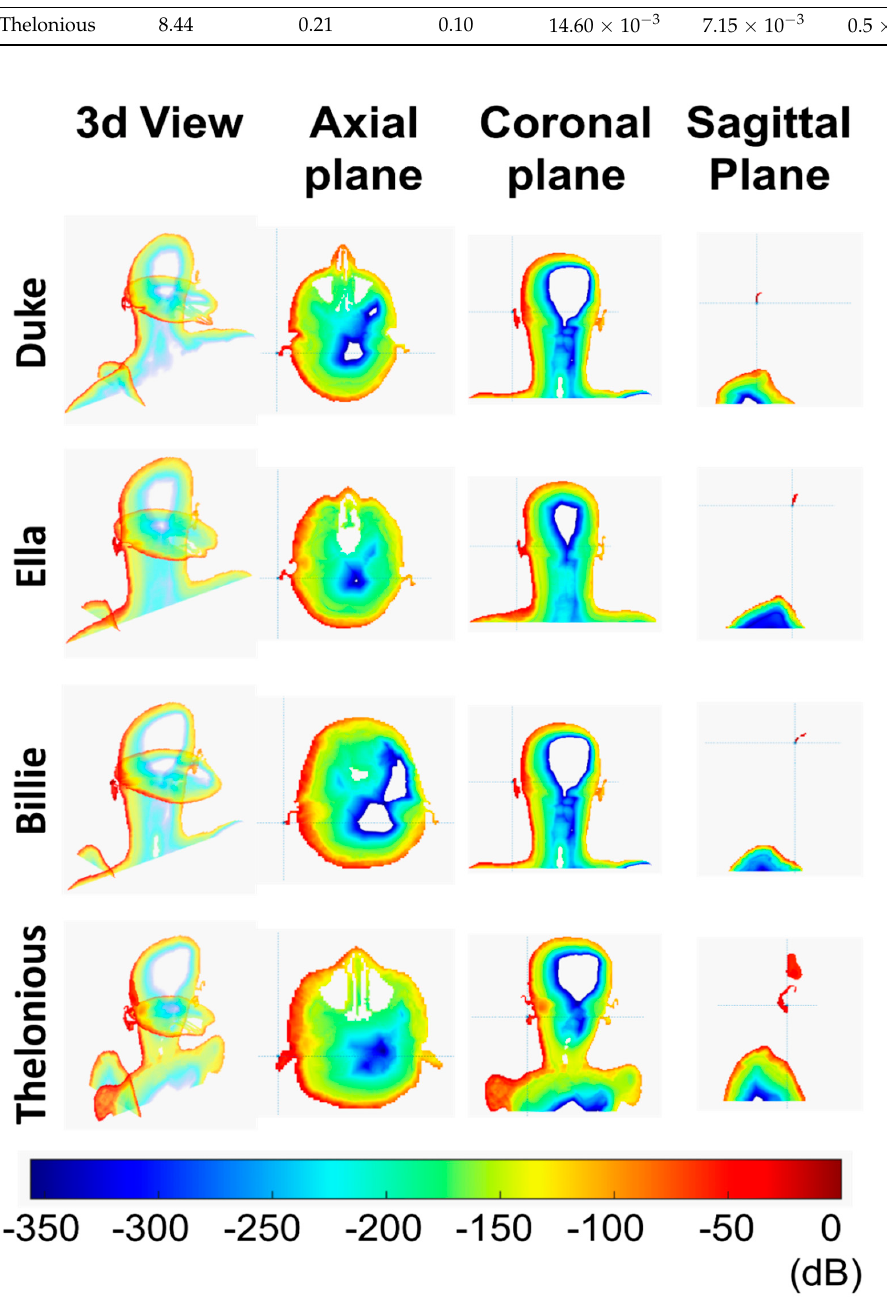
Figure 3. Specific Absorption Rate (SAR) distribution in a phone call scenario in three different planes: axial, coronal, and sagittal. Table 3. SAR depth of penetration and SAR at 1 mm depth (in % with respect to the peak value) for the phone call scenario.